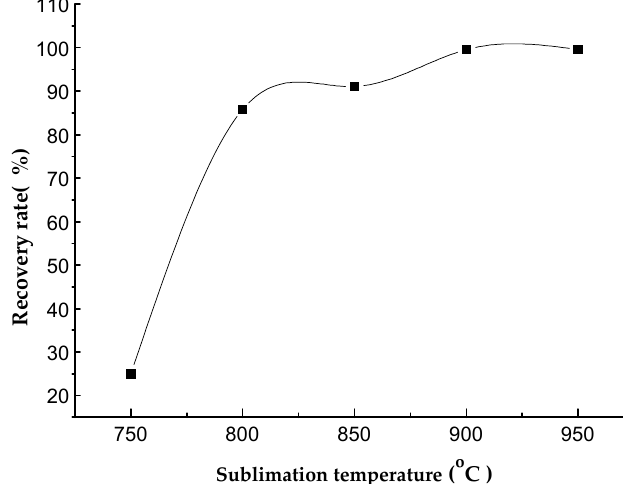
Figure 2. Recycling efficiency of Mo-based catalysts with an increasing sublimation temperature.